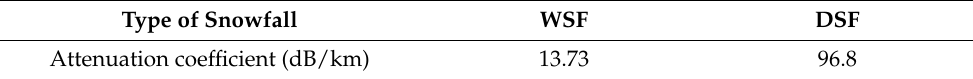
Table 2. Different snowfall conditions with their corresponding attenuation coefficient [30]. Type of Snowfall WSF DSF Attenuation coefficient (dB/km) 13.73